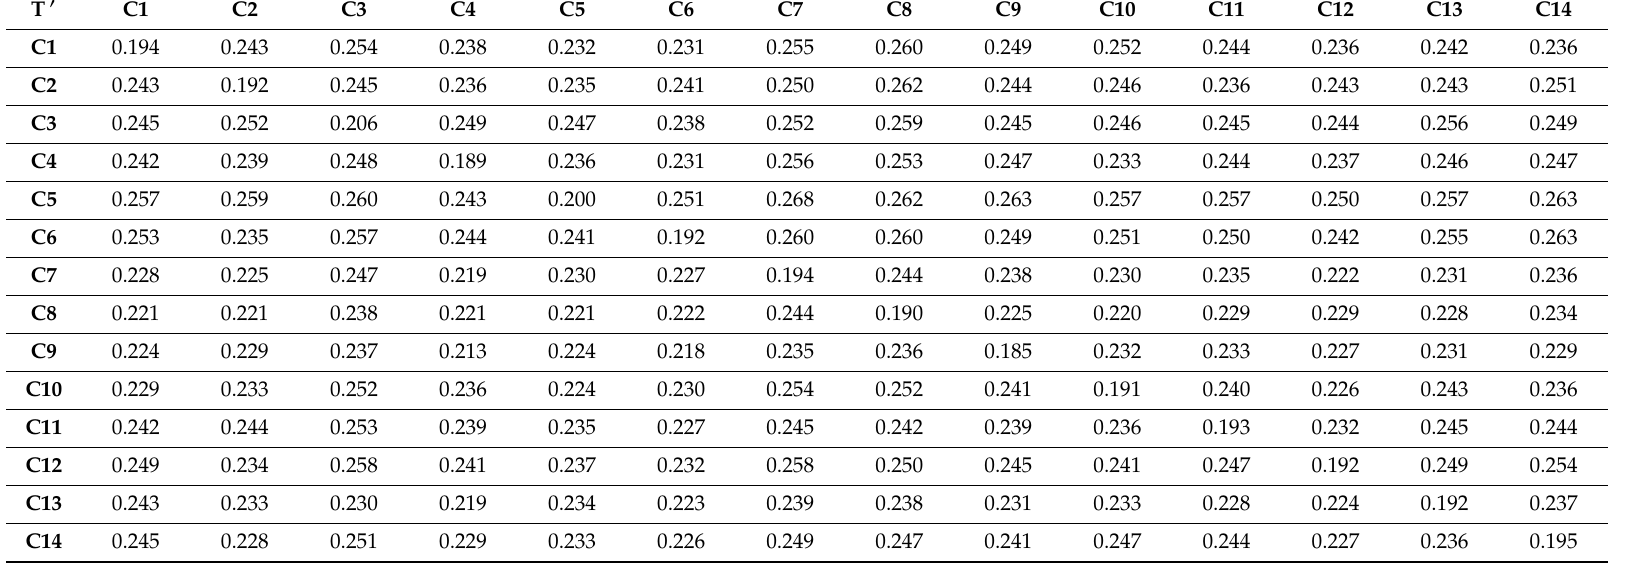
Table 4. The total-relation matrix and the values of each criterion for cause and e ff ect